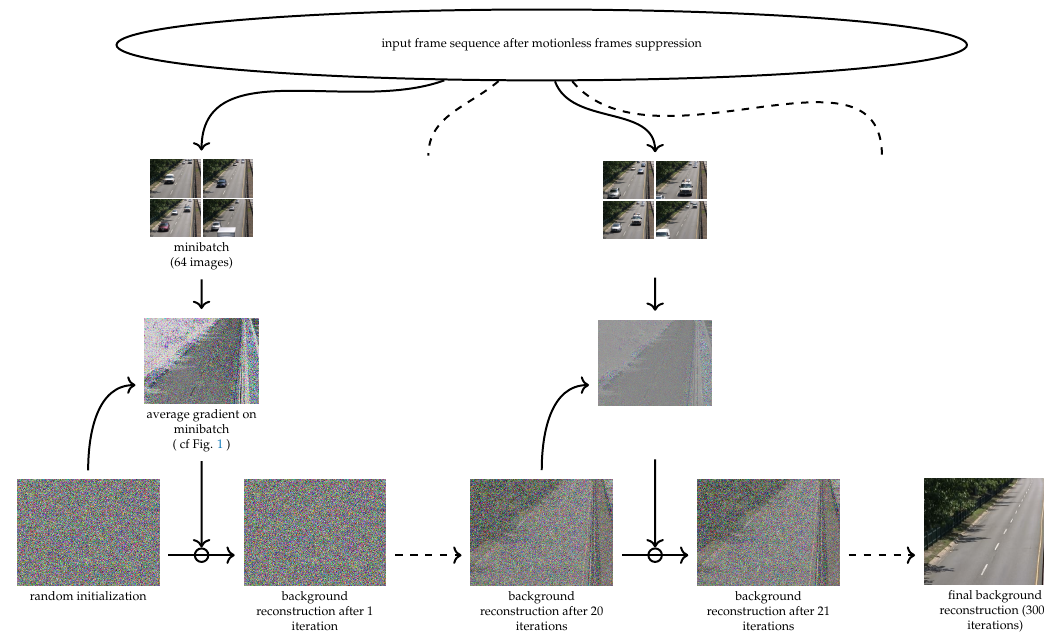
Figure 2. Overview of the stochastic gradient descent optimization